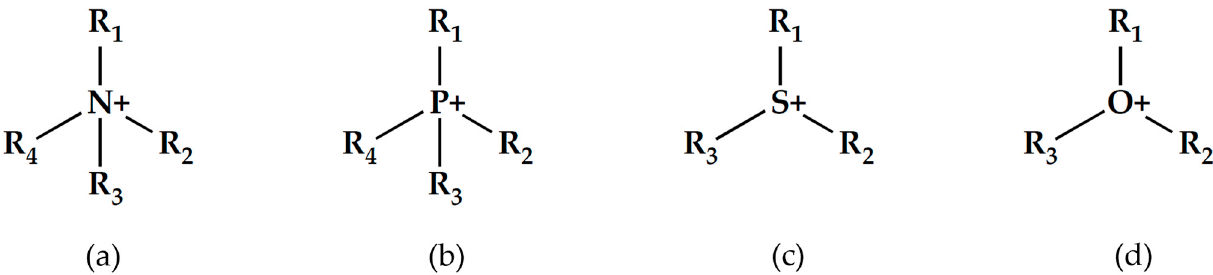
Figure 3. Ionic liquids: ammonium ( a ), phosphonium ( b ), sulfonium ( c ), and oxonium ( d ).